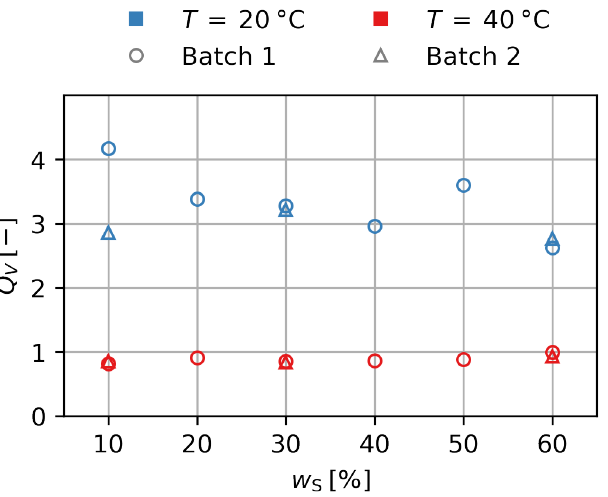
Figure 5. Degree of swelling over mass fraction of particles in the initial state for the first and second batch of